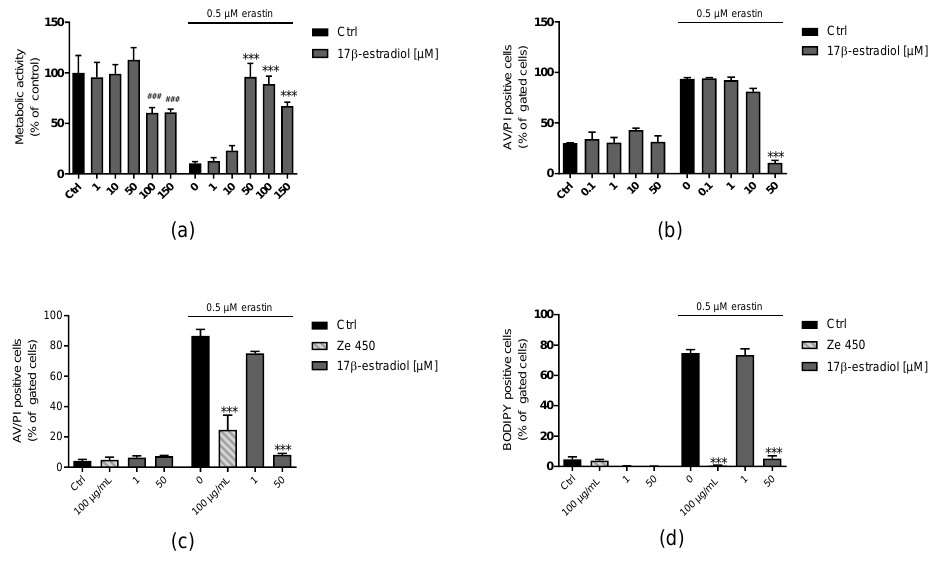
Figure 4. Effects of 17 β -estradiol on HT22 cells. ( a ) Metabolic activity was evaluated in erastin-challenged HT22 cells by measuring MTT formazan absorbance (0.5 µ M, 16 h). Eight replicate wells per condition are displayed as mean + SD. The absorbance under control conditions is set as 100%. ( b , c ) Cell death was assessed by flow cytometry using Annexin V and PI staining after 16 h of treatment in HT22 cells. The bar graph shows one representative experiment with three replicates per sample (mean + SD; 5000 cells per replicate). ( d ) Lipid-peroxidation was assessed by flow cytometry using BODIPY™ after 8 h. The bar graph shows one representative experiment with three replicates per sample (*** p < 0.001, compared to erastin-treated control; ### p < 0.001 compared to untreated control; ANOVA, Scheff é ’s